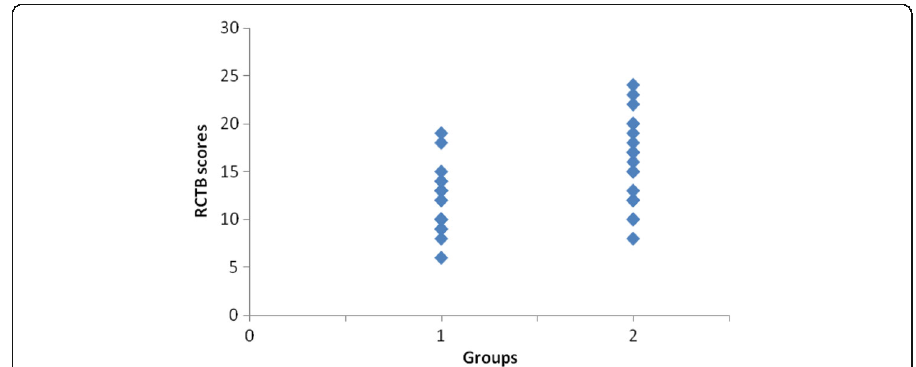
Fig. 1 RCTB performance across groups